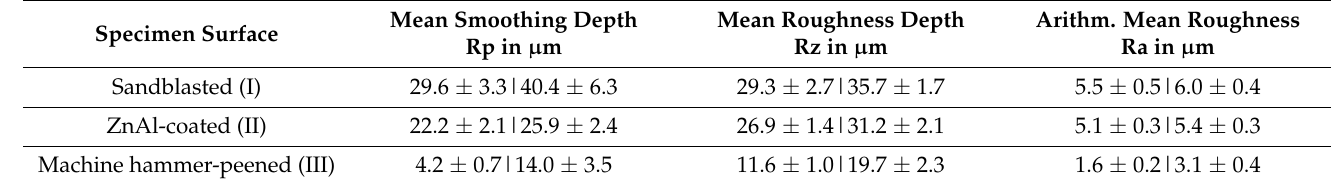
Table 3. Roughness values in gauge length as axial line scan, for two specimens each: Sandblasted (I), ZnAl-coated (II), and machine hammer-peened (III) specimens.